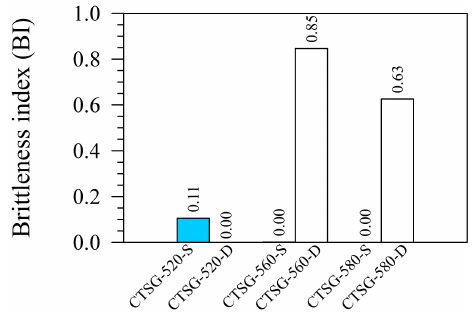
Figure 9. Brittleness